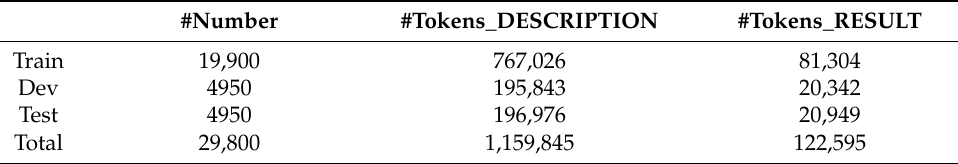
Table 4. Word count statistics of the training and test sets.